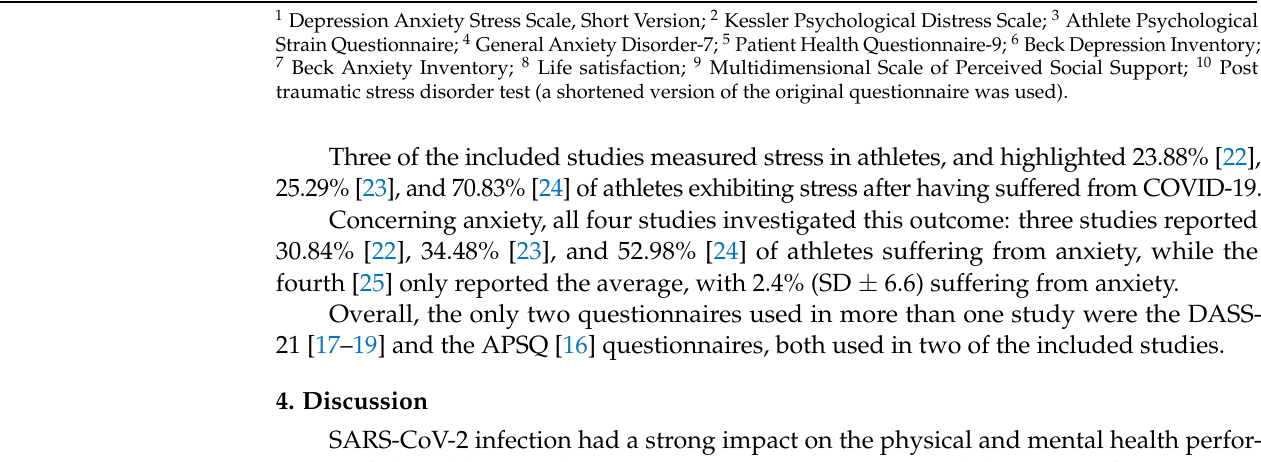
Table 1. Main characteristics of the included studies.